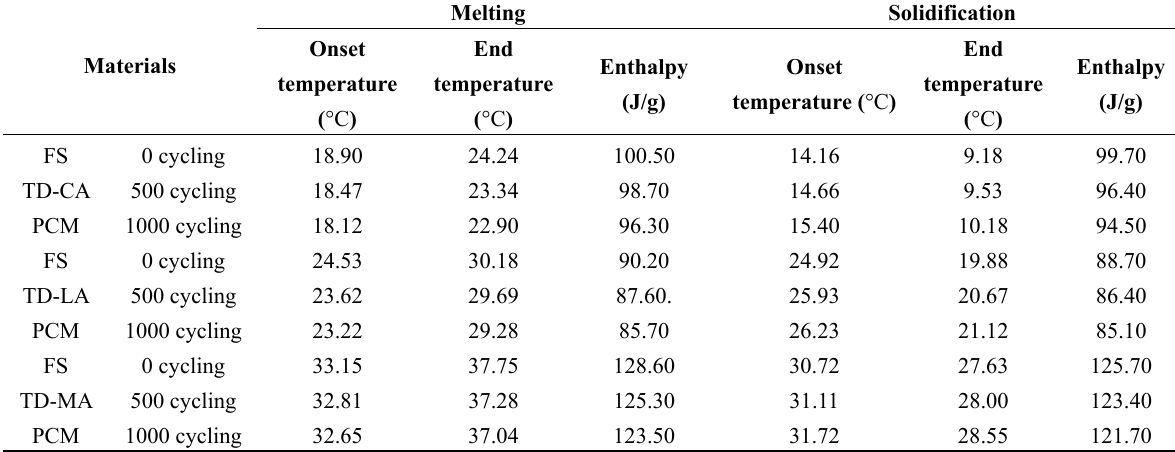
Table 6. Thermal properties of form-stable phase change materials (FSPCMs) before and after